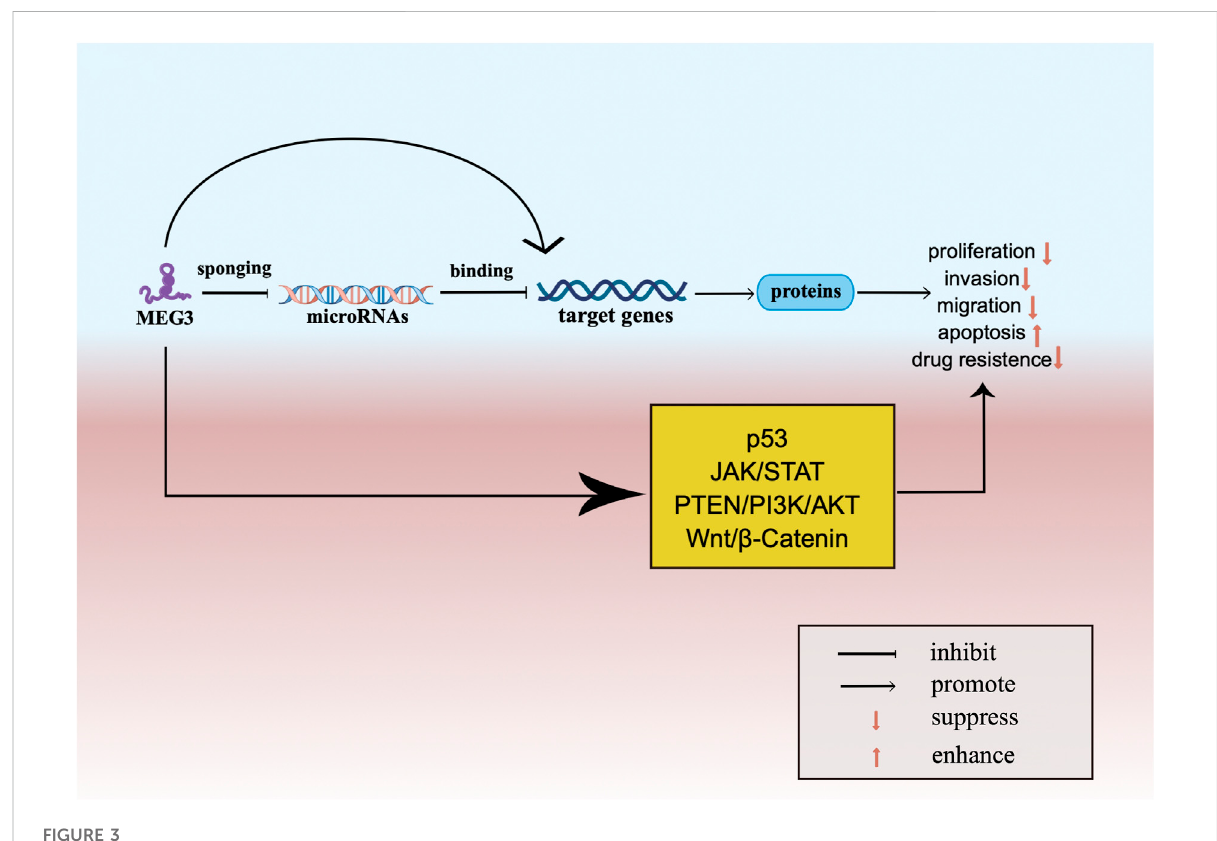
FIGURE 3 MEG3 mediates mechanisms involved in various